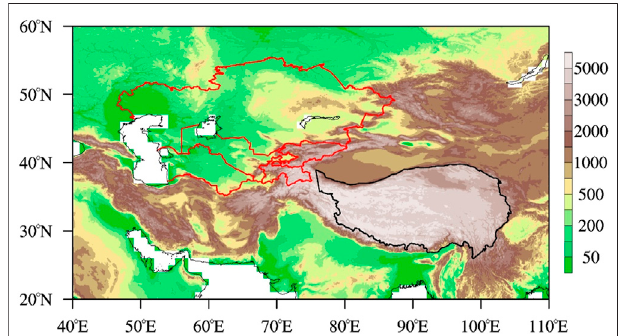
FIGURE 1 | Altitude distribution of the study area. In the fi gure, the area with thick black solid line is the TP, and the area with red solid line is the fi ve countries of Central